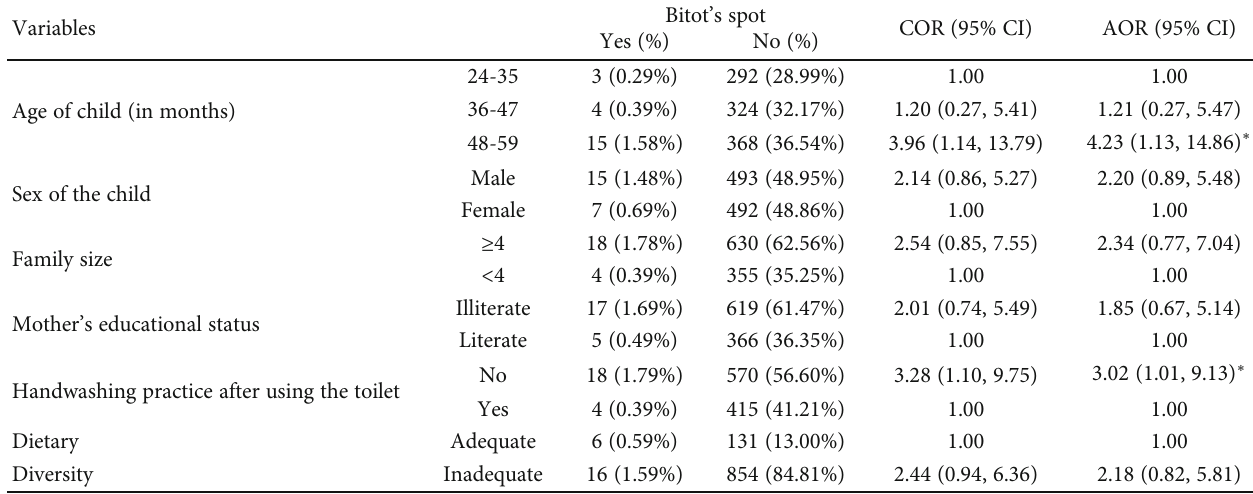
Table 7: Results of bivariate and multivariable logistic regression of Bitot ’ s spot among children aged 24-59 months in Lay Armachiho District, Central Gondar Zone, northwest Ethiopia,